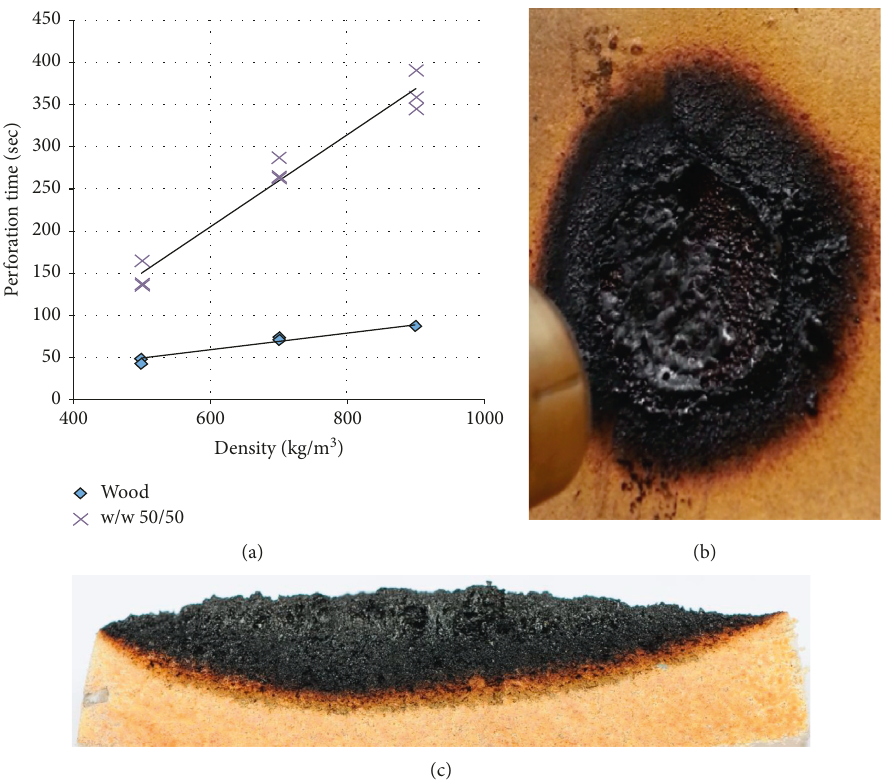
Figure 3: Results from the hot-gun perforation test of wood, wood-leather, and leather fibreboards. (a) Perforation time vs density; (b) appearance of the leather surface after 25minutes of hot-gun exposure; (c) transversal session of the leather (90%) board after 25minutes of hot-gun exposure.